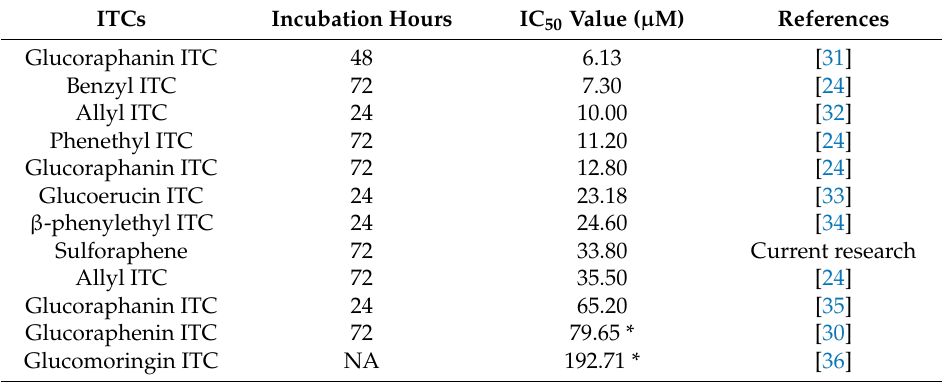
Table 3. Cytotoxicity of several isothiocyanates against HepG2 cell line from various studies. ITCs Incubation Hours IC 50 Value ( µ M) Glucoraphanin ITC 48 6.13